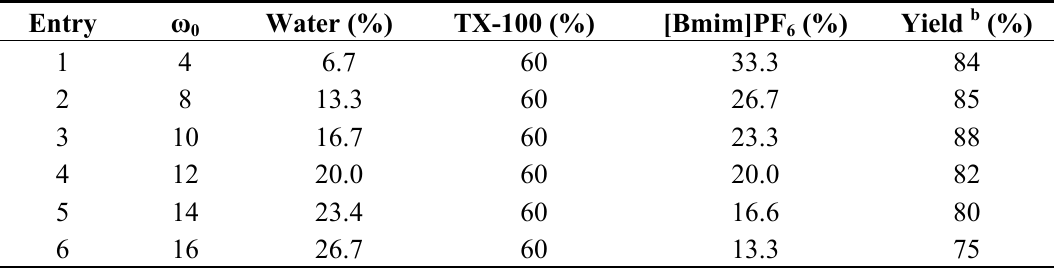
value on the Henry reaction a 0